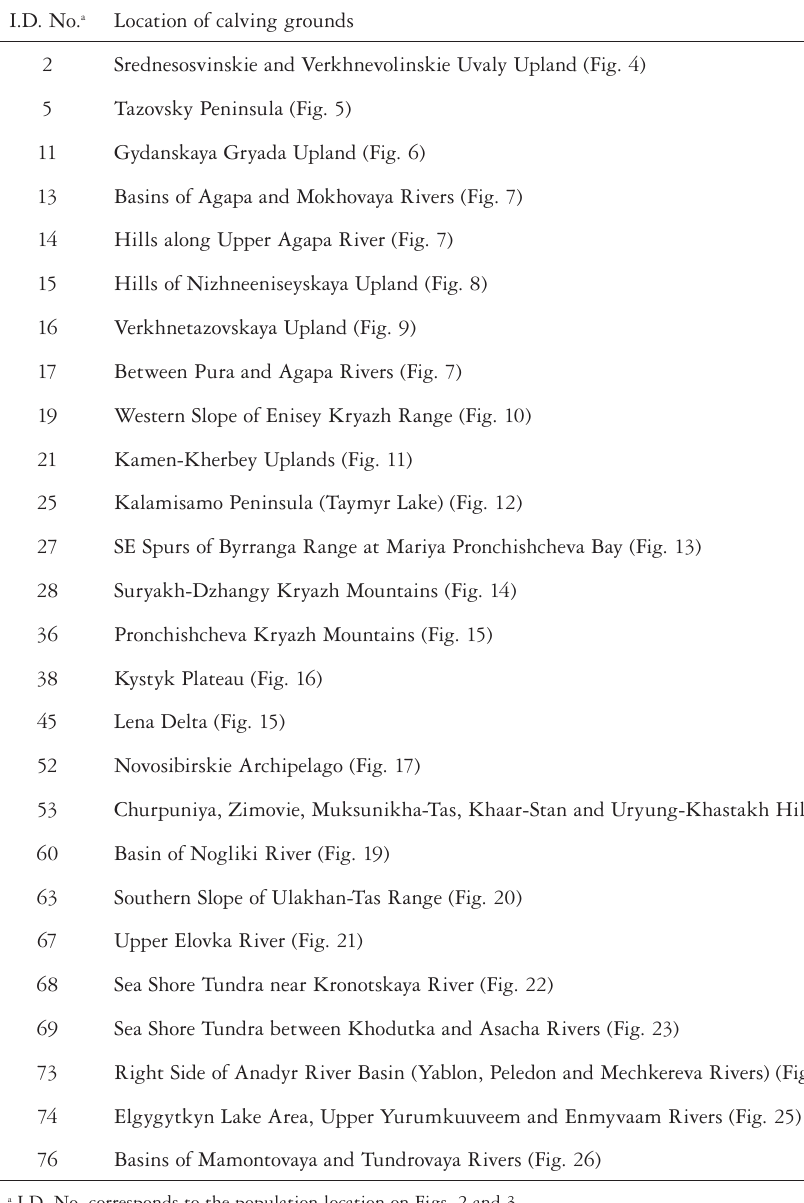
a I.D. No. corresponds to the population location on Figs. 2 and